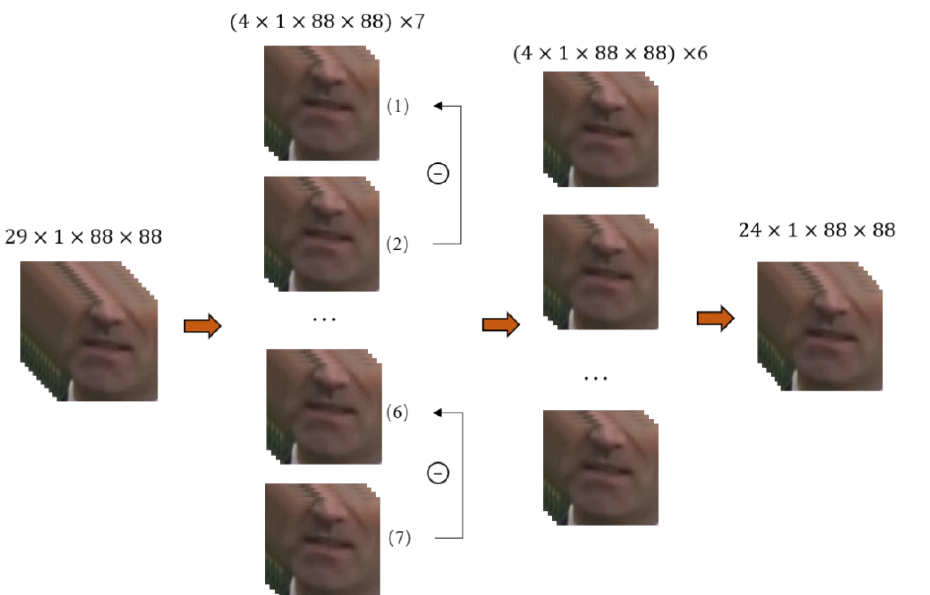
Figure 5. Sparse difference sampling. Given a sequence of 29 frames, we divided it into seven segments, each of which is four frames. Then subtract the previous sub-segment from the current sub-segment, for example subtracting sub-segment 1 from sub-segment 2, sub-segment 2 from sub-segment 3, etc. Finally, splice these segments in the temporal dimension to get a 24-frame result.